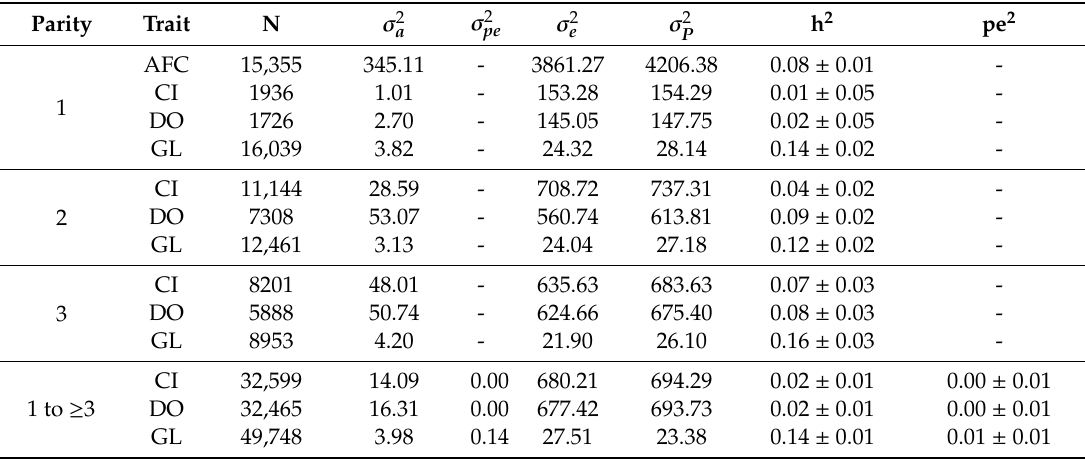
Table 2. Variance components and heritability estimates for reproductive traits of Hanwoo cattle at di ff erent parities using the single-trait model.